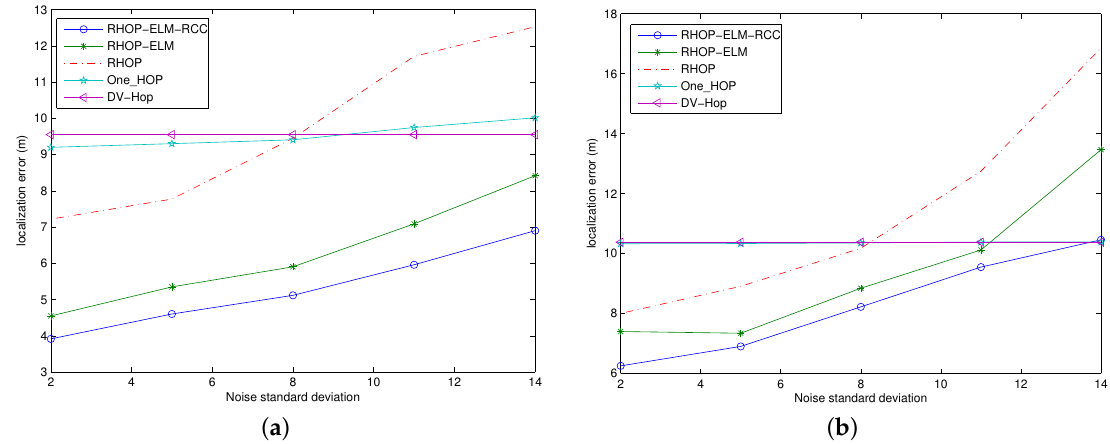
Figure 7. Localization errors against the noise standard deviation. ( a ) The case with 50 nodes in the area of 50 m × 50 m; ( b ) The case with 100 nodes in the area of 100 m × 100